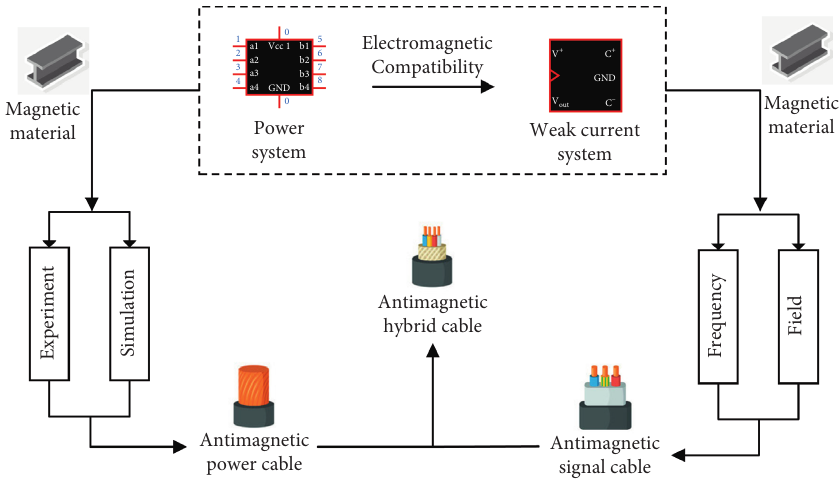
Figure 8: Shielding